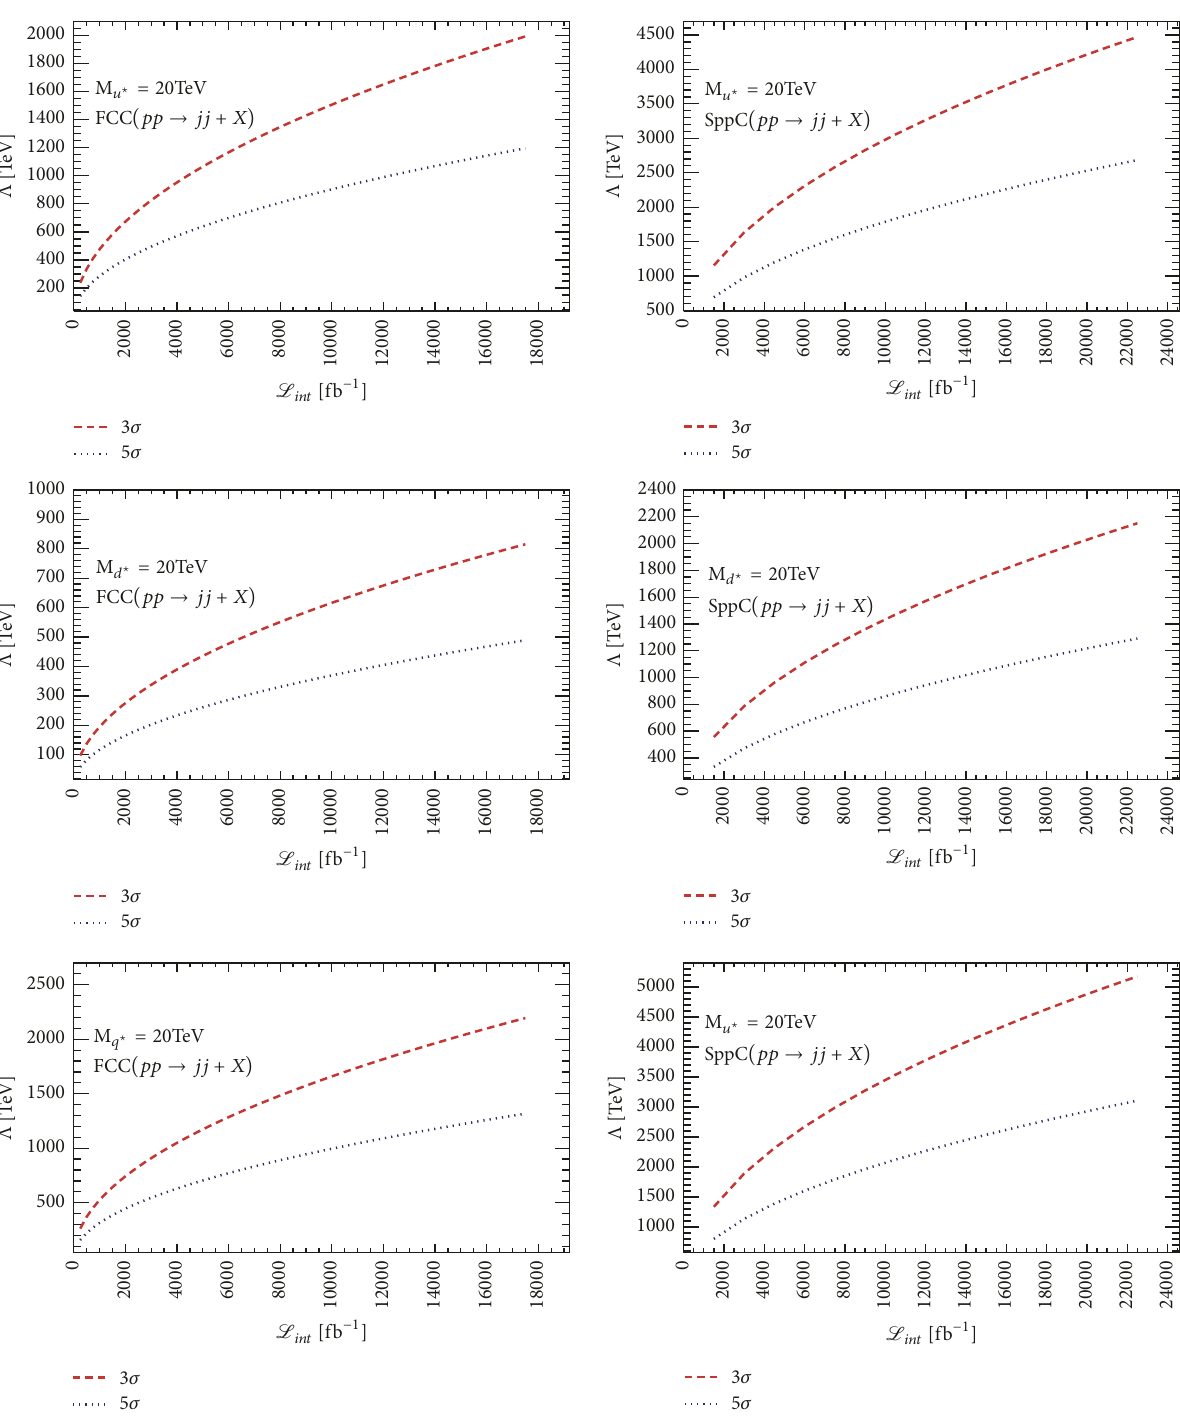
Figure 7: Compositeness scale-luminosity correlation plots for the FCC (left column) and SppC (right